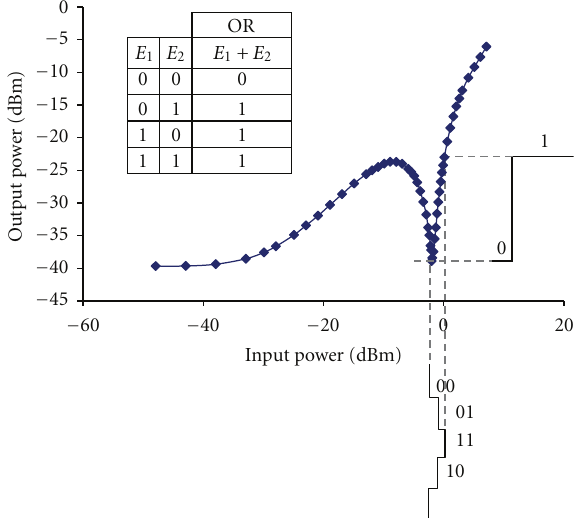
Figure 5: Measured static transfer function and principle of ope- ration for OR function at a blocking power equal to − 2 dBm and wavelength equal to 1550 nm.